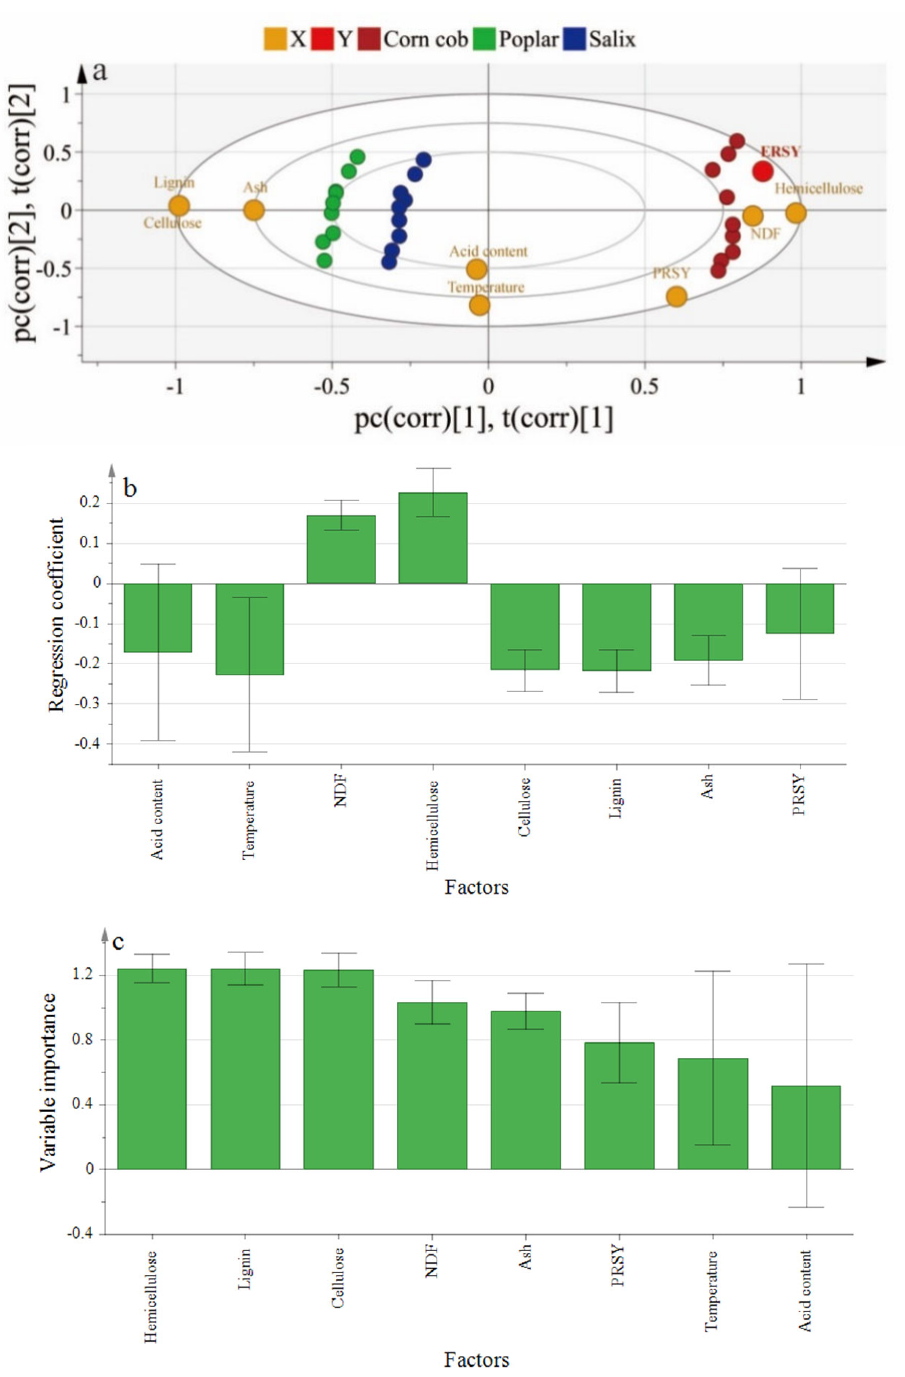
Figure 5. PLS model 4 analysis for the acid pretreatment followed by enzymolysis. ( a ) Biplot. ( b ) Regression coefficients of X variables on the Y variable. ( c ) Importance of X variables on the Y variables for the projection.